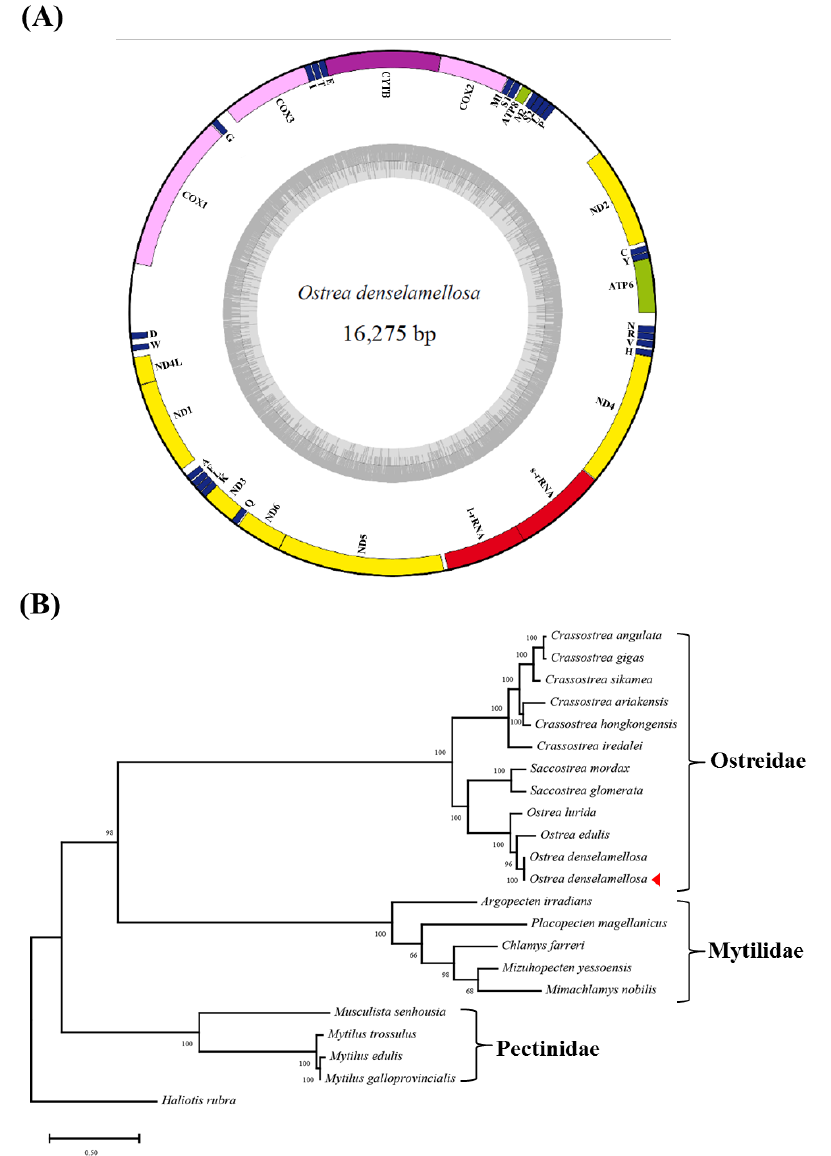
Figure 3. ( A ) The mitochondrial genome map of Ostrea denselamellosa and ( B ) Maximum-likelihood phylogeny of 21 published complete mitochondrial genomes based on 12 concatenated nucleotide sequences of protein-coding genes. The red triangle indicates the O. denselamellosa strain analyzed in this study.